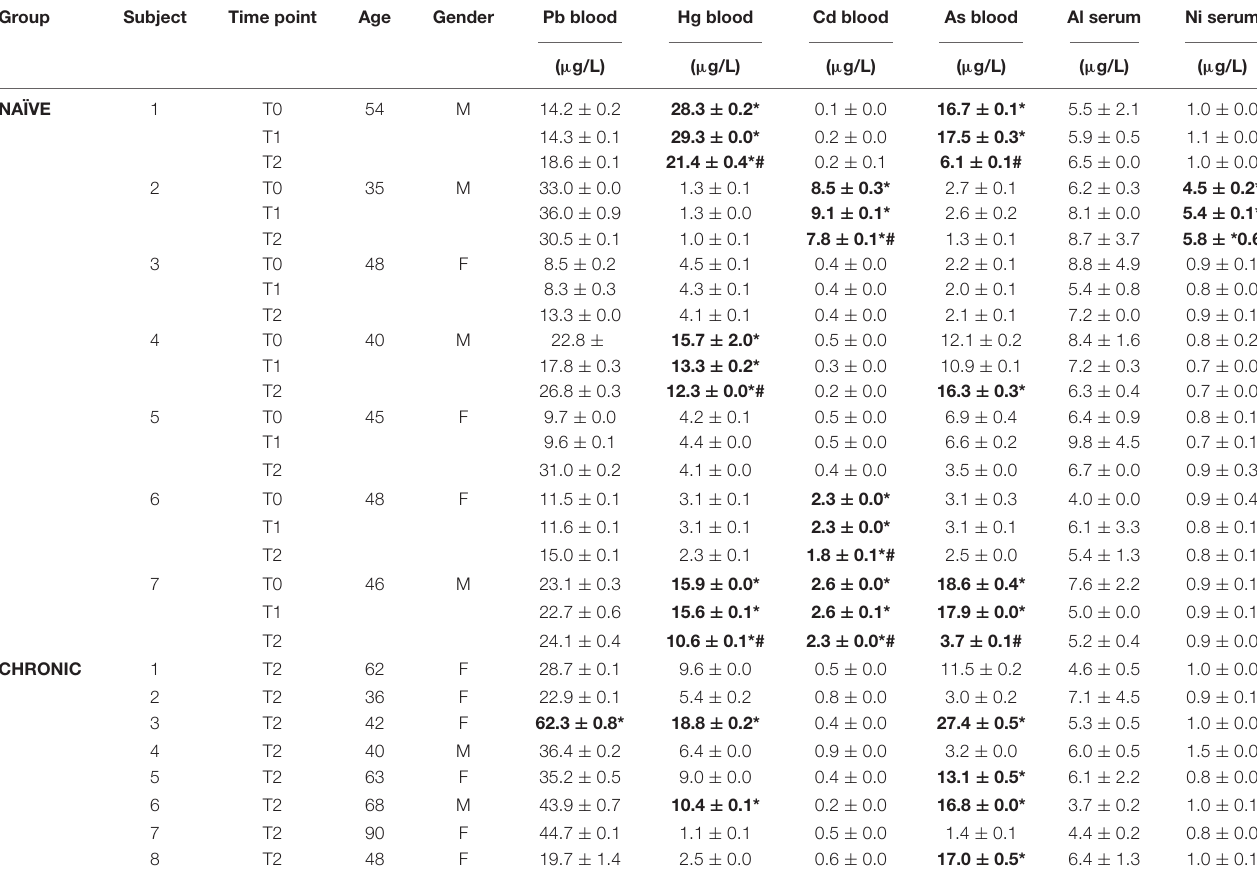
TABLE 4 | Metal concentrations in tested subjects enrolled in the MMBP study (NCT04607018) by ICP-MS analysis.